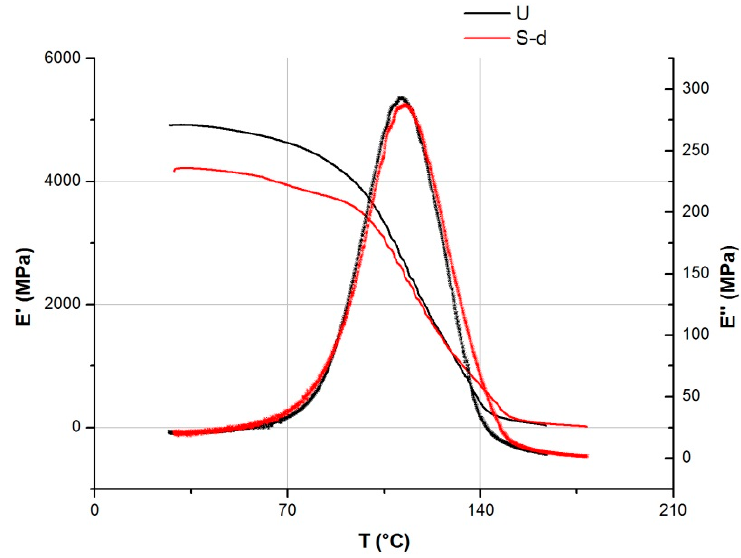
Figure 9. DMA curves of PET-SiOx film before (black) and after (red) the SAM process execution.